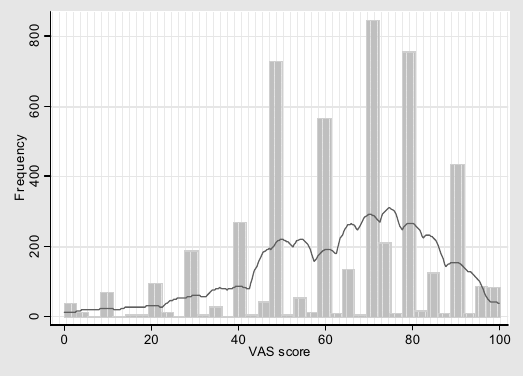
Figura 1 – Istogramma di frequenza e stima Kernel